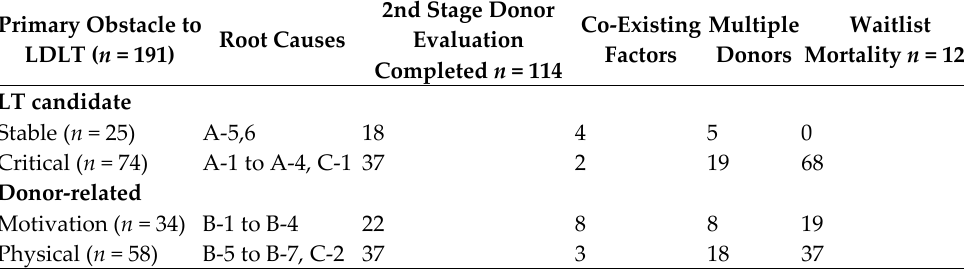
Figure 3. Root-cause analysis of failed live liver donations. ( A ). Fishbone diagram illustrating potential barriers to preemptive LDLT. ( B ). Category summary. LDLT, live donor liver transplant; LT, liver